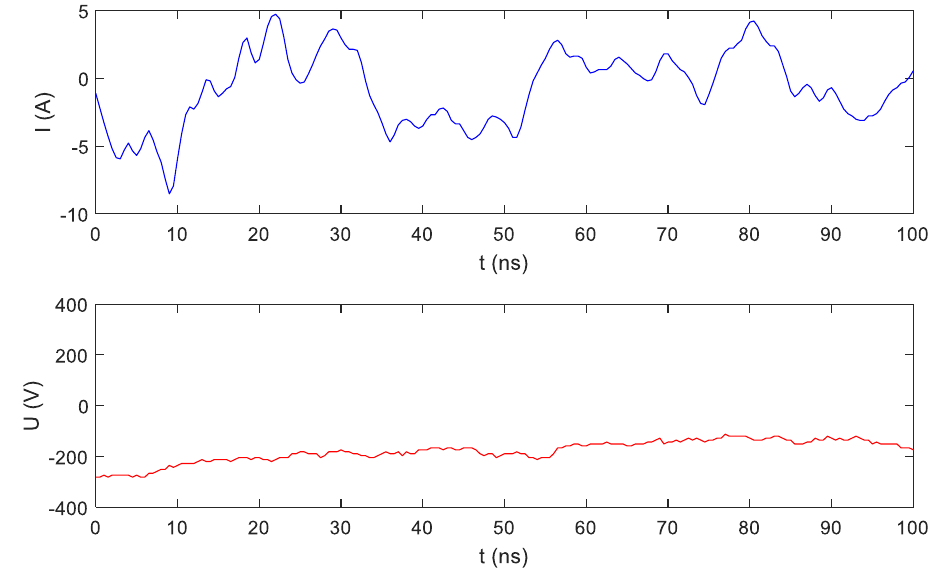
Figure 10. Extra-high-frequency (EHF) voltage and current recorded with frequency sampling of 2 Gs/s during LED bulb (A) operation in steady state (SS).